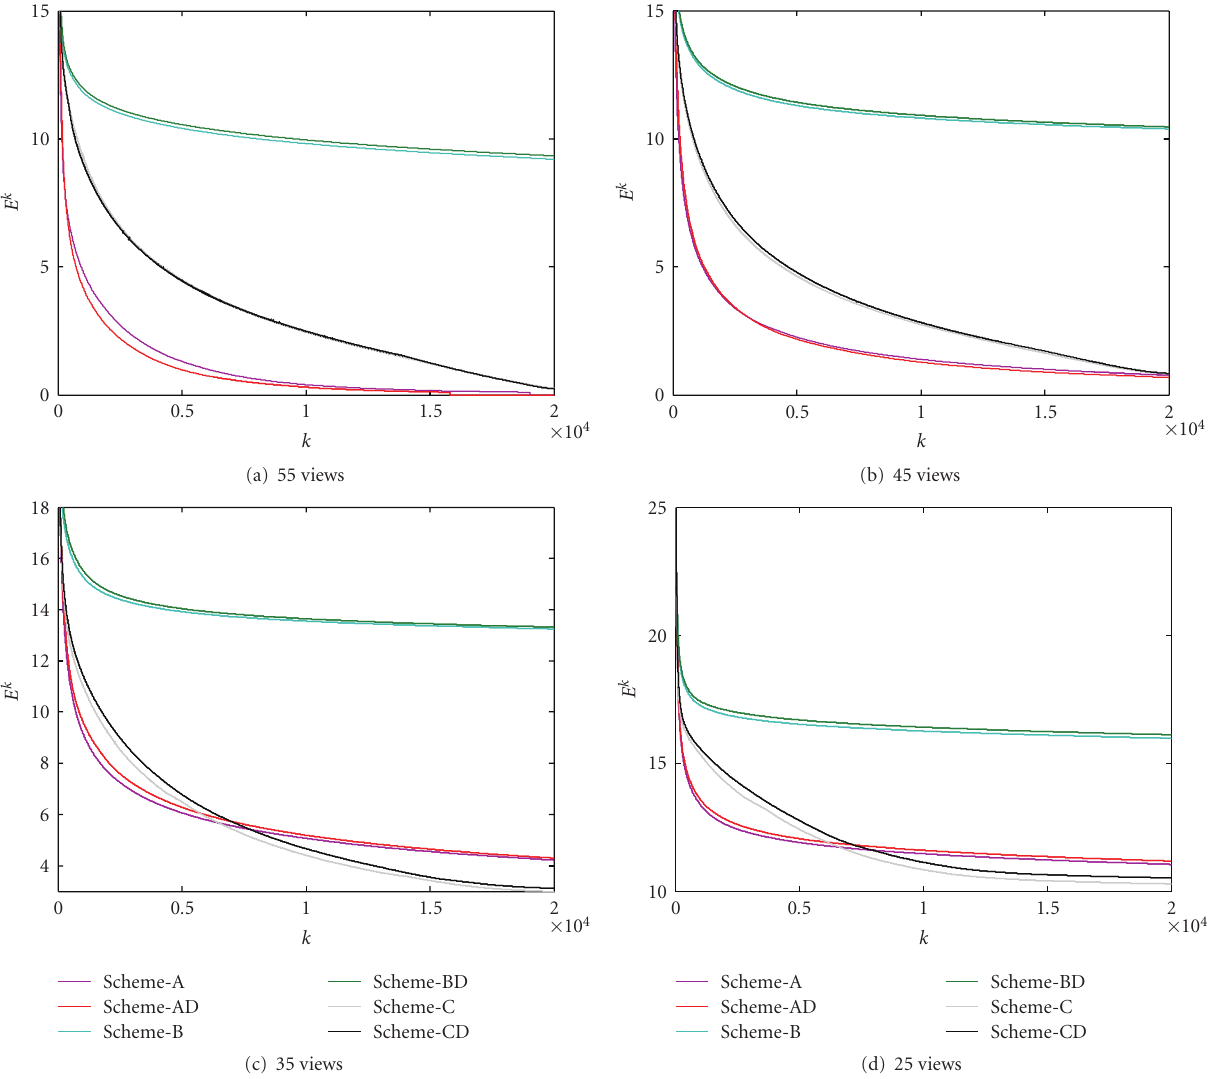
Figure 2: Relative error curves for various reconstructions from noise-free projections. The numbers of projections were set to (a) 55, (b) 45, (c) 35, and (d) 25, respectively, where the horizontal and vertical axes represent the iteration index k and the corresponding log error E k ,